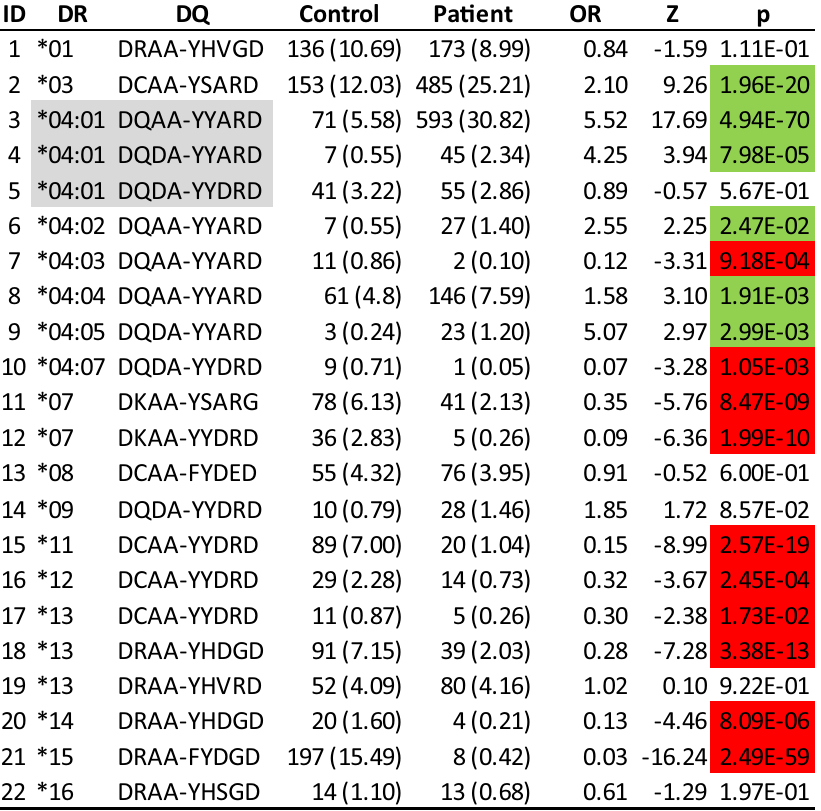
Table 5. Haplotype association analysis of type 1 diabetes with HLA-DRB1 and DQA1/B1: estimated haplotype frequency (%) among control and patient, estimated odds ratio, Z-score, and p-value, for those haplotypes with five or more